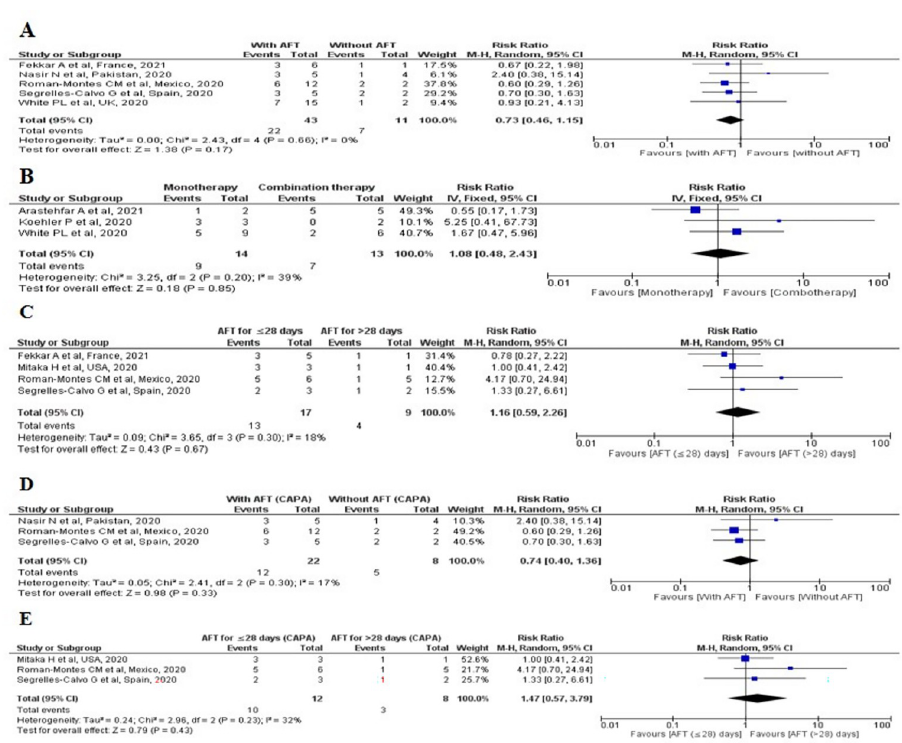
Fig 2. All-cause mortality associated with fungal secondary infections among COVID-19 patients who used AFT. ( A): All-cause mortality associated with AFT and without AFT in fungal secondary infections among COVID-19 patients; (B): All-cause mortality associated with mono- and combination AFT in fungal secondary infections among COVID-19 patients; (C): All-cause mortality associated with duration of AFT in fungal secondary infections among COVID-19 patients; (D): All-cause mortality associated with AFT and without AFT in patients with CAPA and (E): All-cause mortality associated with duration of AFT in patients with CAPA.